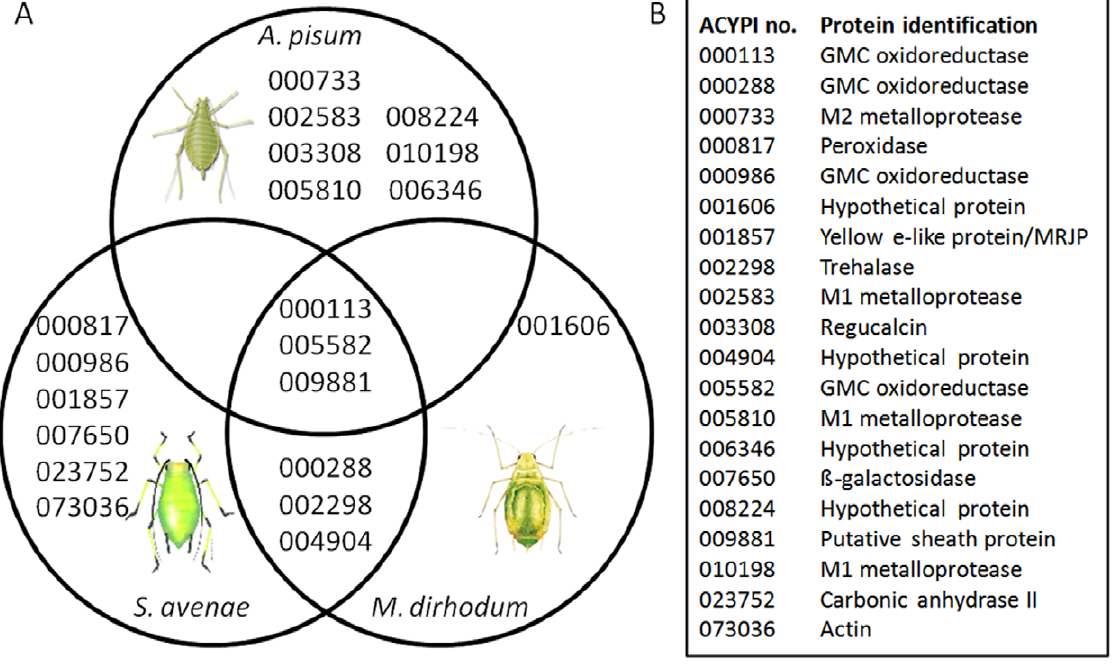
Figure 2. Distribution of proteins identified to date from the secreted saliva of Acyrthosiphonpisum , Metopolophiumdirhodum and Sitobionavenae. Numbers in (A) are the ACYPI numbers referred to in (B) with their associated protein identification. Images not to scale.